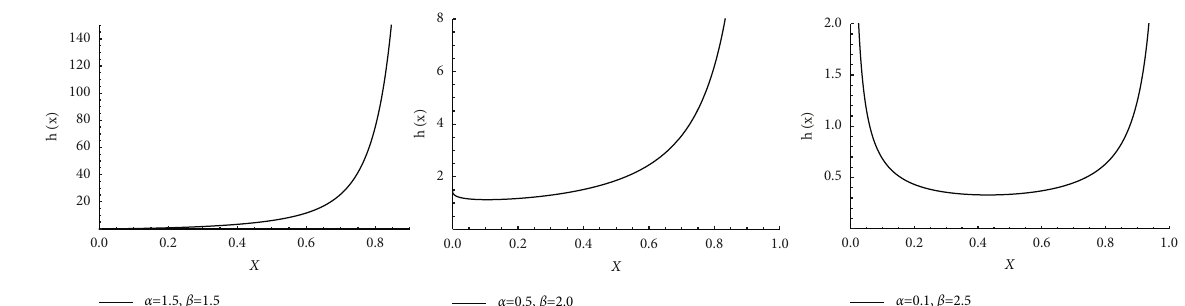
Figure 2: Plots of the HF of the ExRKD with various parametric